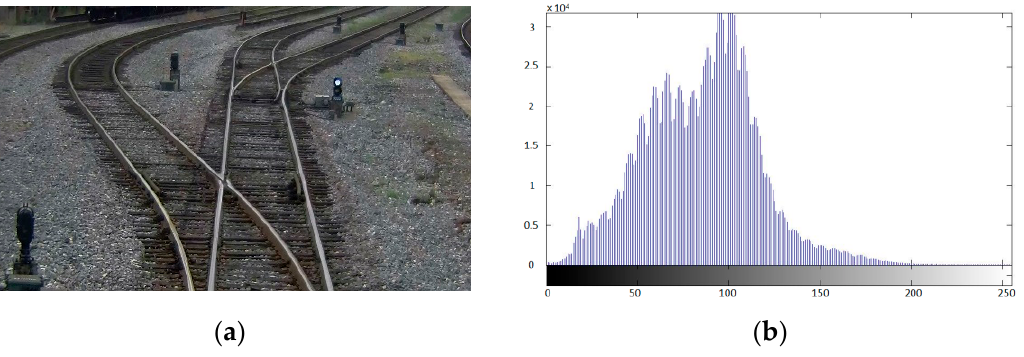
Figure 3. ( a ) presents the original image of freight track and ( b ) shows the gray histogram image of freight track.